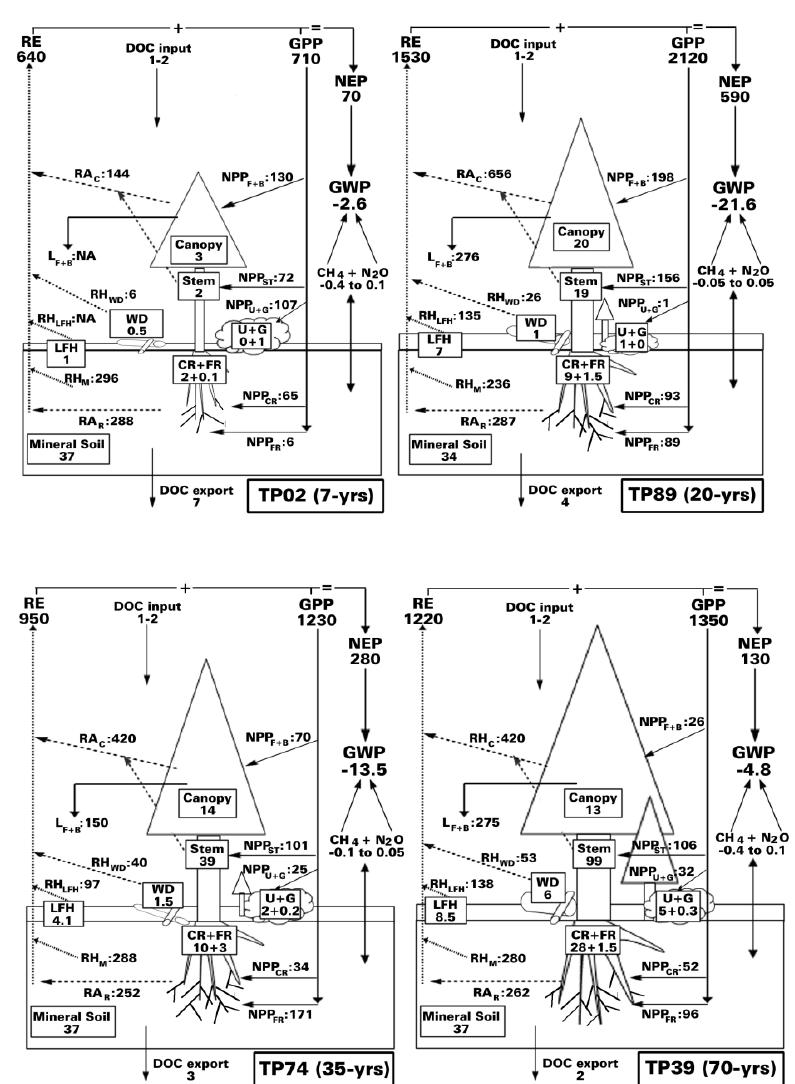
Figure 3. Ecosystem carbon (C) pools (square boxes; t Cha − 1 ), C fluxes (gross and net primary production (GPP, NPP), litter-fall and DOC flux = solid arrows, ecosystem respiration (RE) fluxes = dotted arrows; gCm − 2 year − 1 ), CH4 and N2O fluxes ( t CO 2 eqha − 1 year − 1 ) and GHG balance expressed as global warming potential (GWP; t CO 2 eqha − 1 year − 1 ) at the four Turkey Point pine forest sites, TP02, TP89, TP74 and TP39. Abbreviations: C = canopy; F = foliage; B = branches; ST = stem; LFH = forest floor; WD = woody debris; CR = coarse roots; FR = fine roots; U = understorey; G = ground vegetation; M = mineral soil; R = roots; RH = heterotrophic respiration; RA = autotrophic respiration; L = litter-fall; DOC = dissolved organic carbon; NA = not available